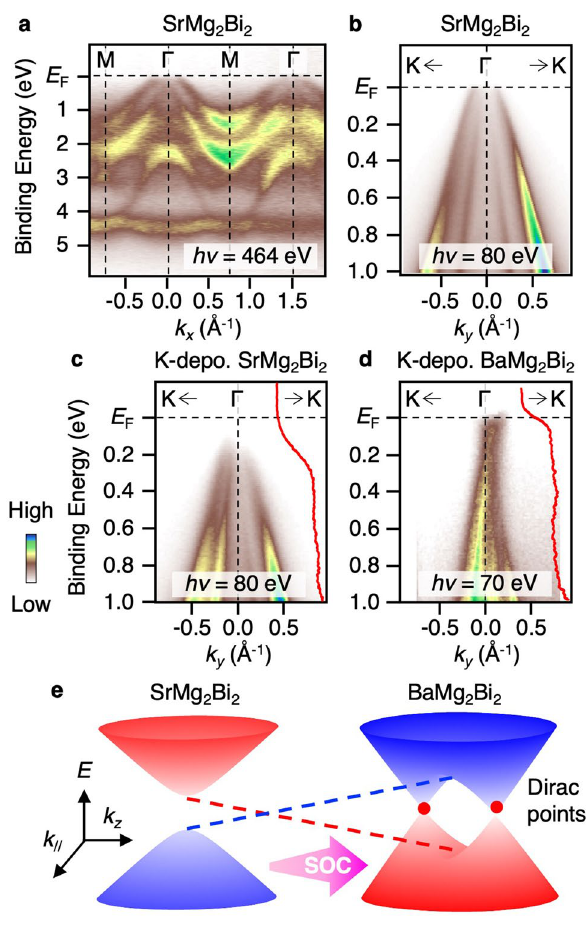
Figure 4. ( a ) VB ARPES intensity of SrMg 2 Bi 2 measured at T = 40 K along the ΓM cut at hν = 489 eV. ( b , c ) ARPES intensity in the vicinity of E F of SrMg 2 Bi 2 before and after K deposition, respectively, measured almost along the ΓK cut (cut #1 in Fig. 3b) at hν = 80 eV. ( d ) ARPES intensity for K-deposited BaMg 2 Bi 2 (same as Fig. 3c). EDCs at the Γ point are shown in ( c ) and ( d ). ( e ) Schematic band diagram of X Mg 2 Bi 2 suggested from the ARPES